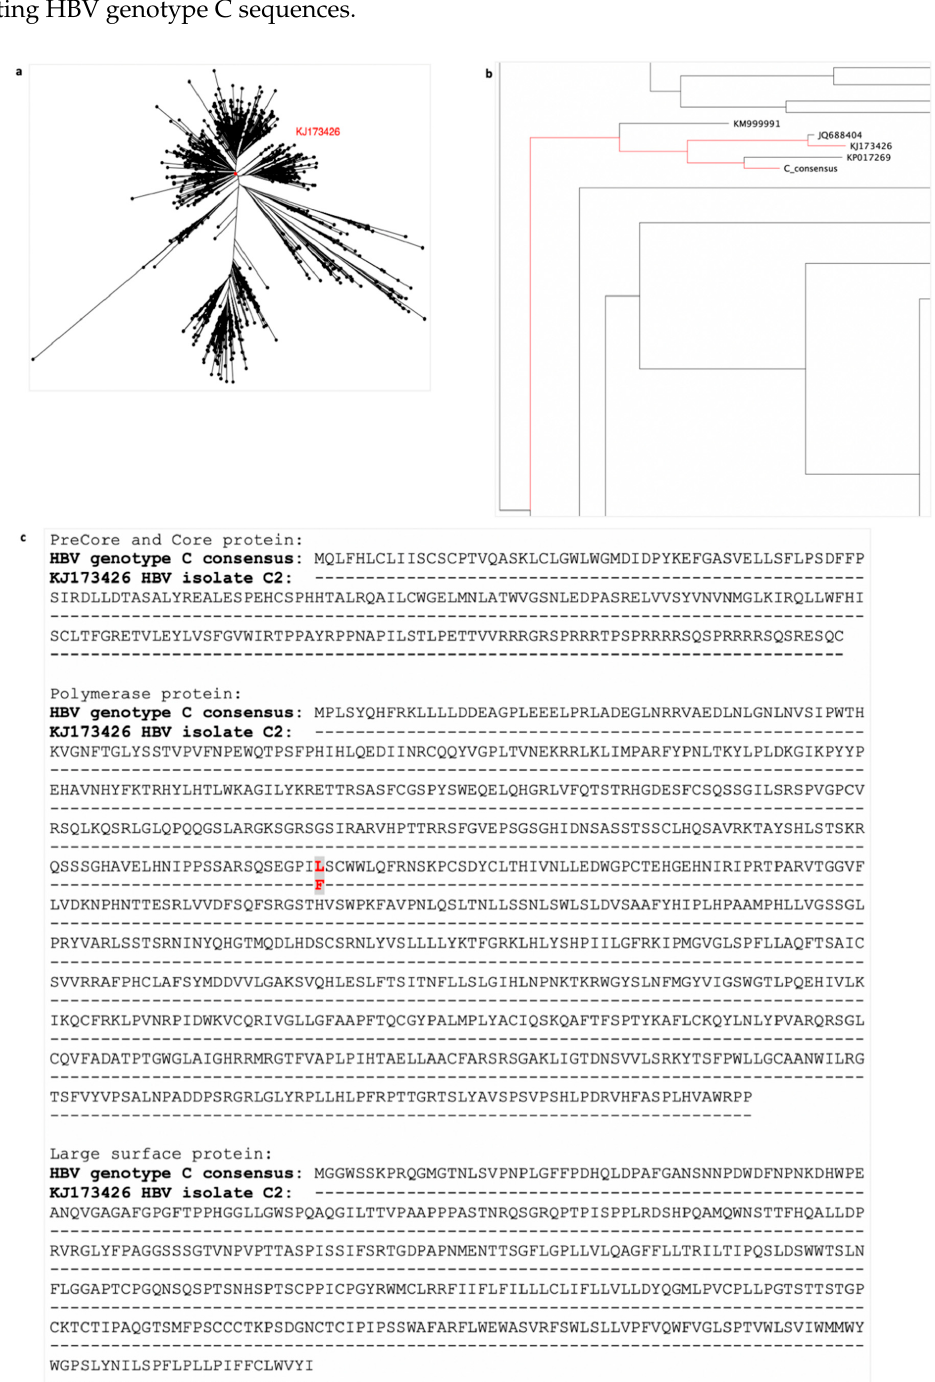
Figure 1. Selection of a patient’s hepatitis B virus (HBV) sequence for HBV genotype C immunogen